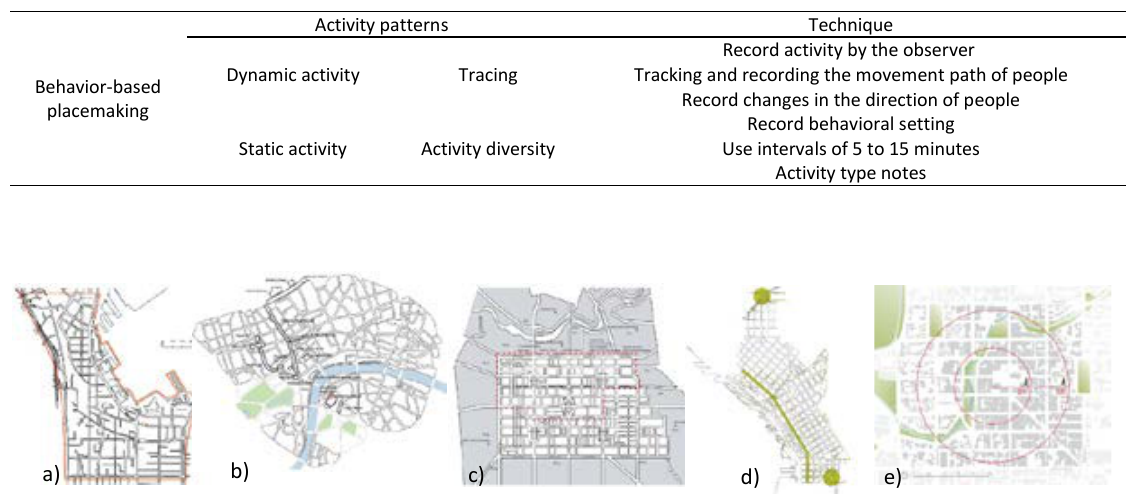
Table. 3: Behavioral observation methodology